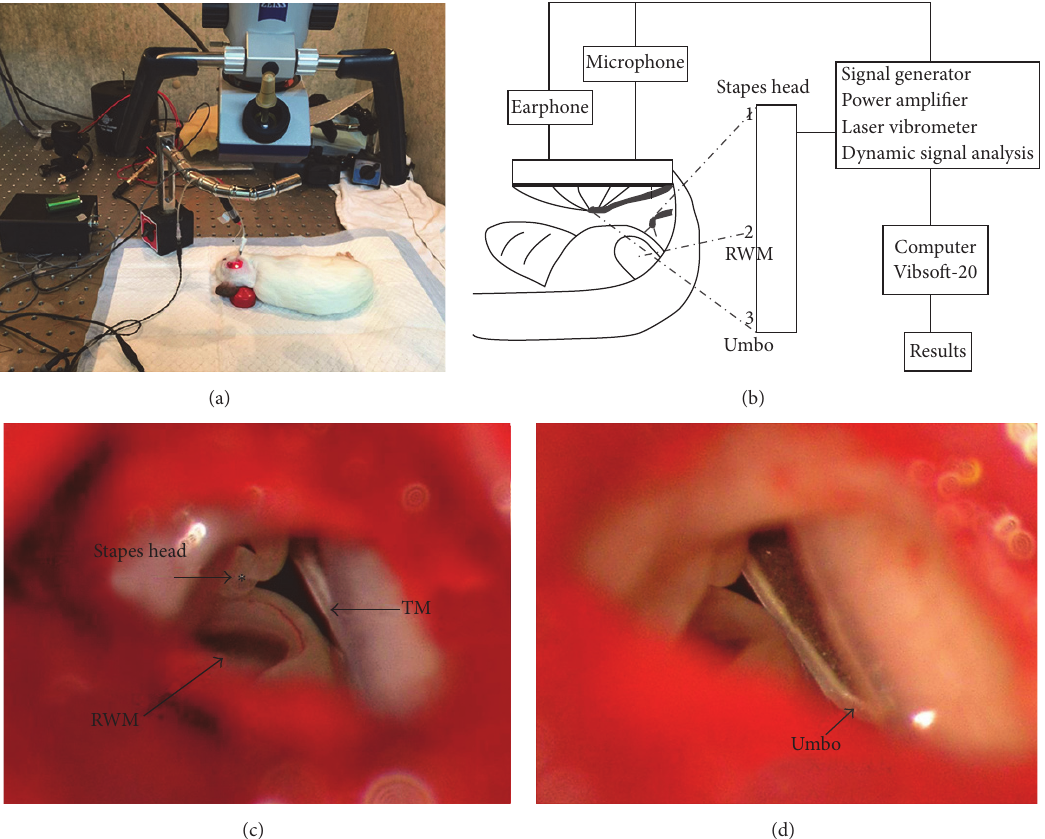
Figure 1: (a) the measurement system included a Compact Laser Vibrometer coupled with a microscope with a micromanipulator, signal generator, and power amplifier. (b) The schematic diagram of the laser Doppler vibrometer (LDV) detecting system. (c and d) The incus- stapes complex, round window membrane, and the medial side of the umbo, viewed from the opened middle ear cavity. The laser reflective tapes were placed at the location marked with an ∗ ((c) stapes head and middle of the RWM; (d)